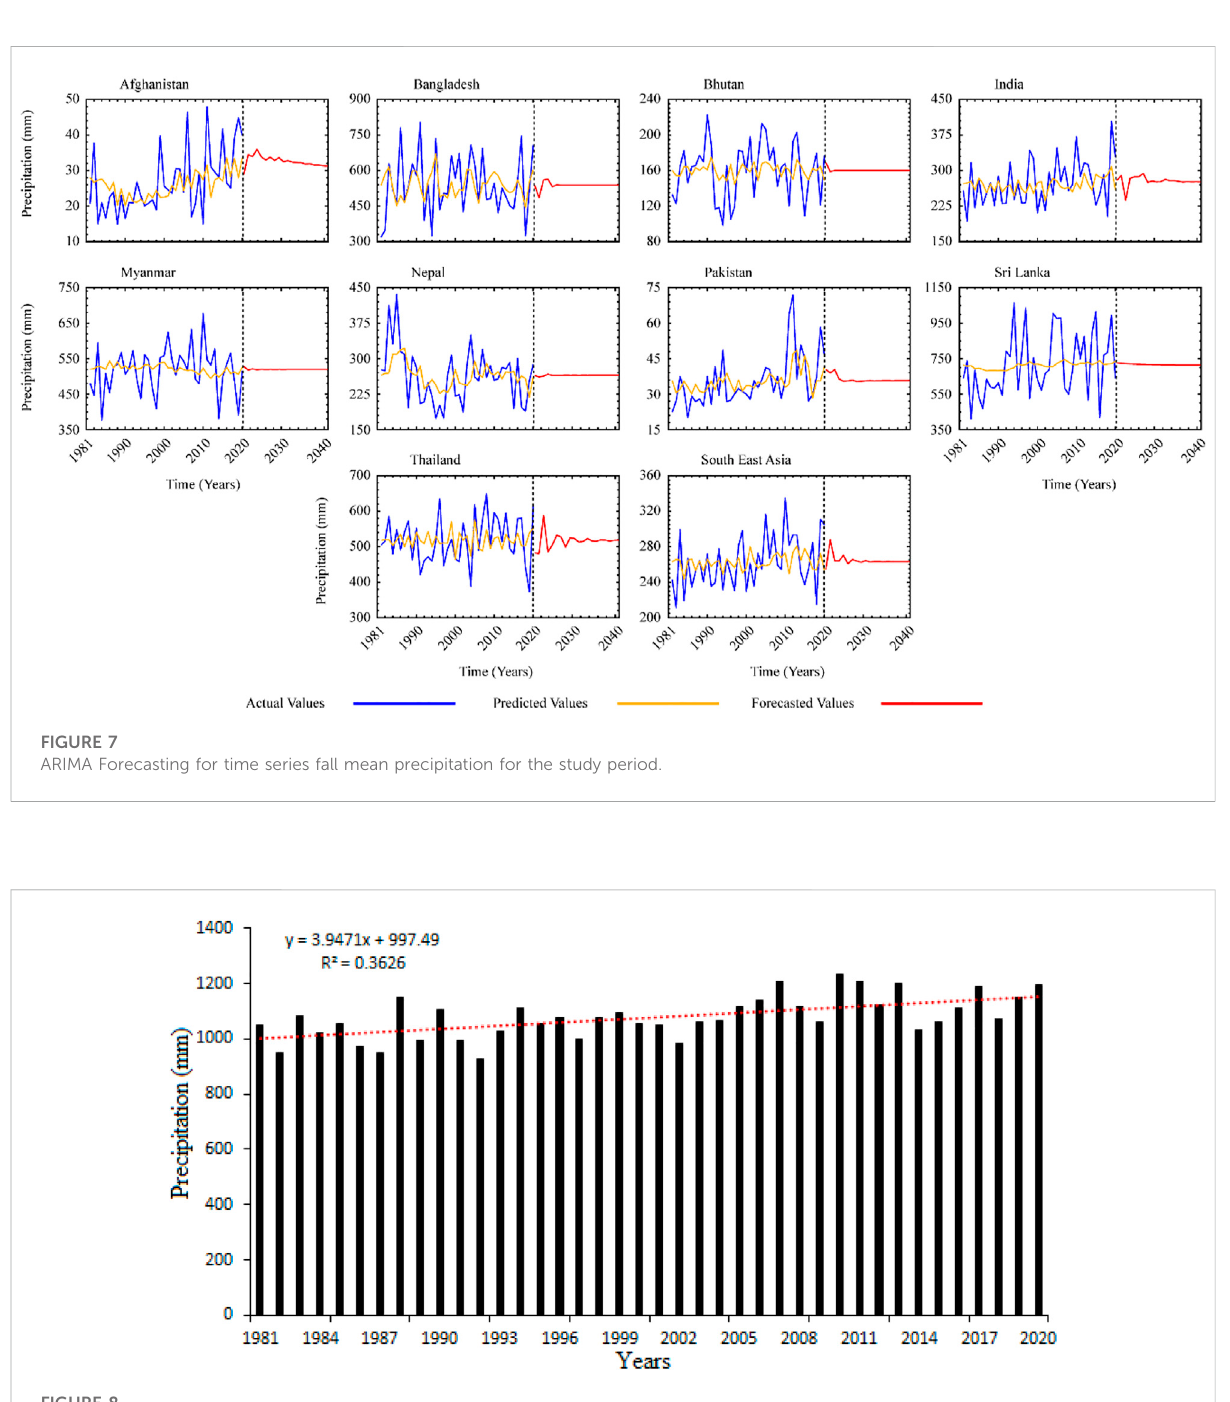
FIGURE 8 Total annual precipitation in the SEA during 1981 – 2020 (black bars), with the linear trend line (red dotted